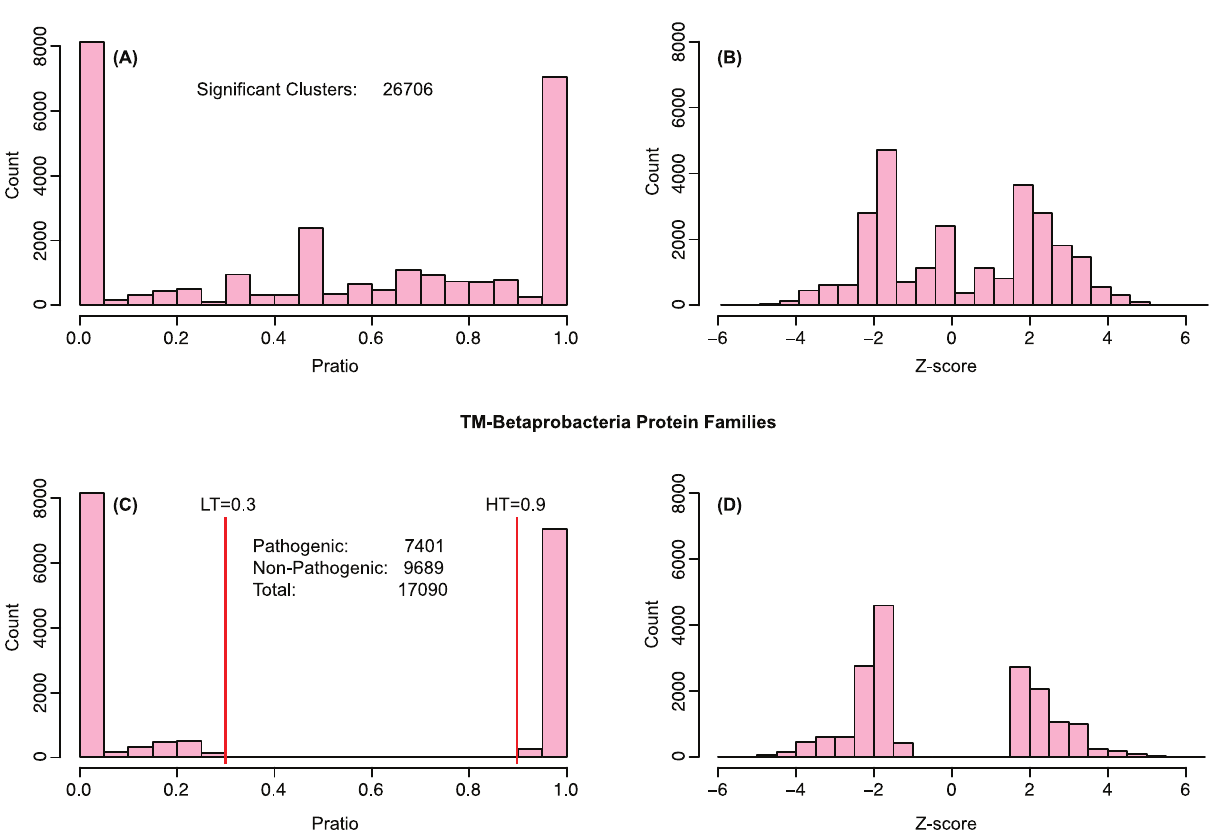
Figure 1. P ratio and Z-score histograms for TM-Betaproteobacteria model. The model was built setting MinOrg=2, HT=0.9 and LT=0.3. (A) and (B) respectively show the P ratio and Z-score histograms for the clusters i such that ORG i $ MinOrg. By this step the original 69,744 clusters are reduced to 26,706. In (A) the bars at the extremes are the count for clusters containing either only genes from pathogenic organisms (right bar) and non-pathogenic ones (left bar), while the small pick in the middle are clusters containing the same number of pathogenic and non-pathogenic organisms, and hence will not be used since they provide no discriminative information about pathogenicity. (C) and (D) show the same histograms for the PFs obtained removing all the significant clusters with P ratio value between LT and HT. We can see how the amount of non-pathogenic PFs is higher than the pathogenic ones (C). HT and LT can be used to modify the amount of both pathogenic and non-pathogenic PFs, which can be useful in model in which the training-set has an unbalanced amount of pathogenic and non-pathogenic organisms. In (D) the negative Z-scores are associated with non-pathogenic families while the others are for pathogenic PFs.